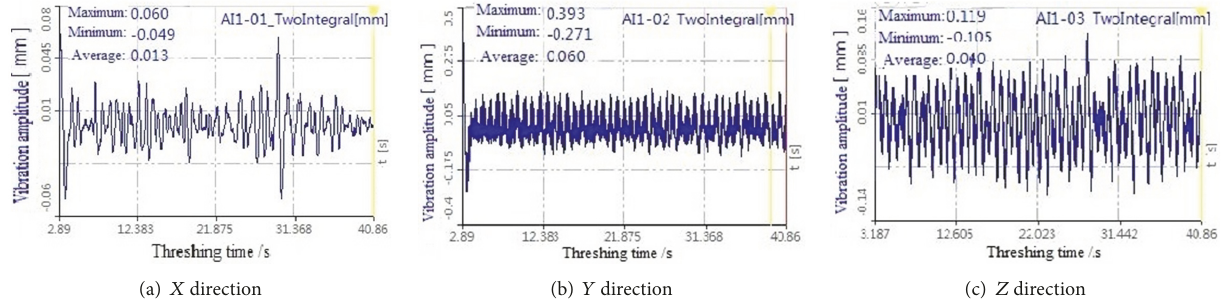
Figure 10: Time-domain vibration signal of no-load cylinder rotation.